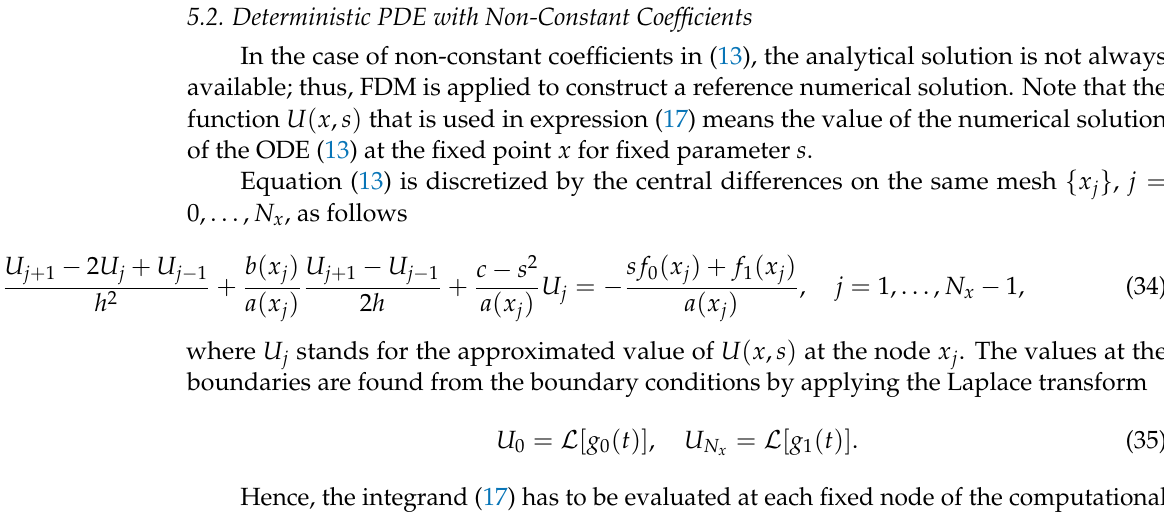
Figure 2. Error and total computational time of the midpoint rule with respect to the domain size R with fixed h = 10 − 1 for Example